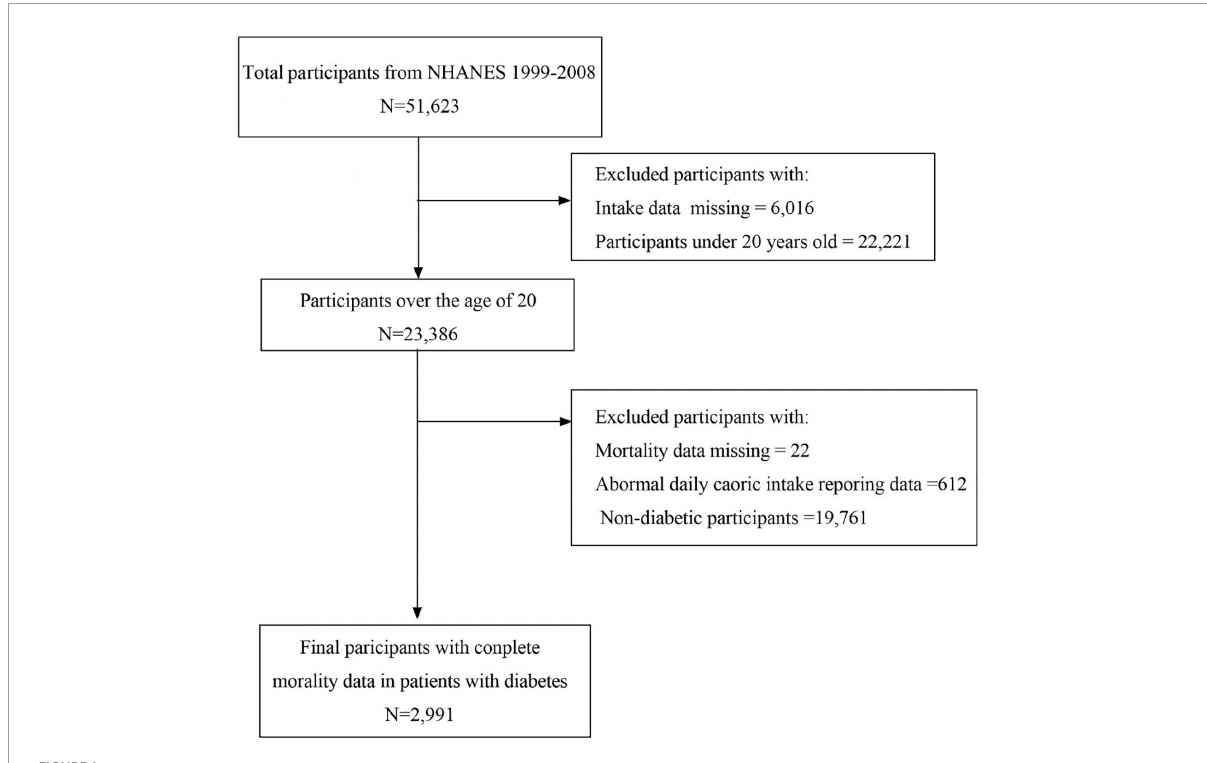
FIGURE1 Flow chart of sample